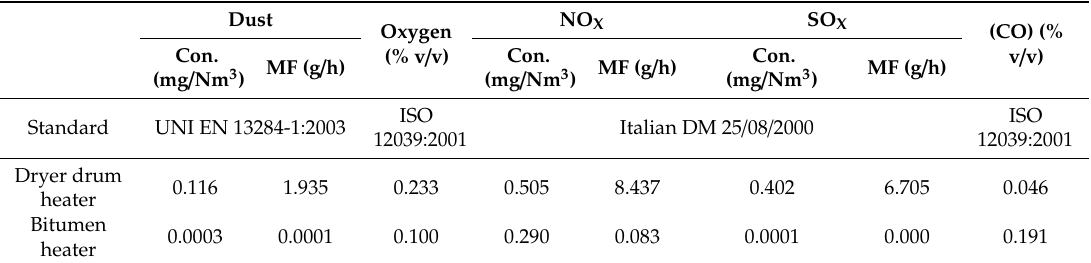
Table 6. Direct measures of emission in atmosphere in two plant locations for the DU.